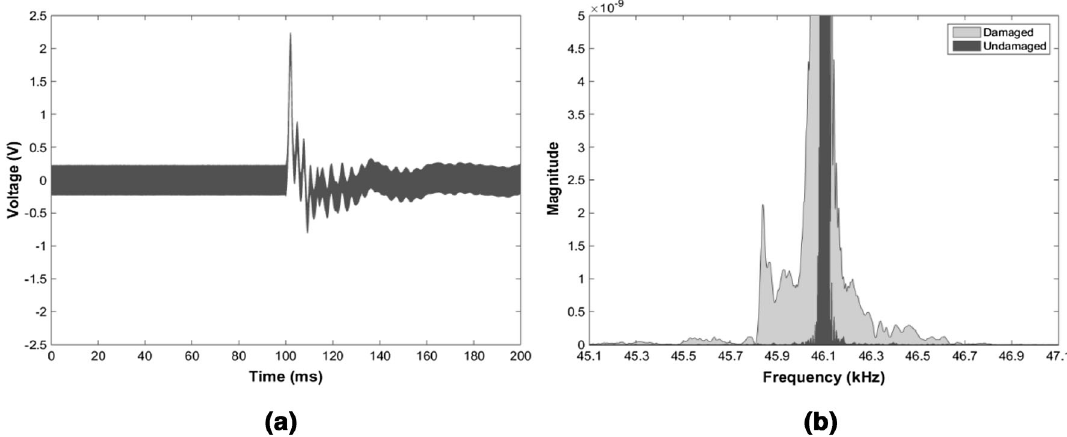
Fig. 4 The modulated high frequency wave of samples. a Modulation signal in time domain and b frequency